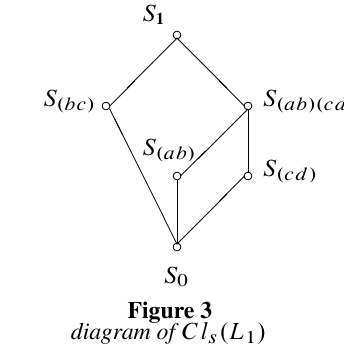
Figure 3 diagram of Cl s .L 1